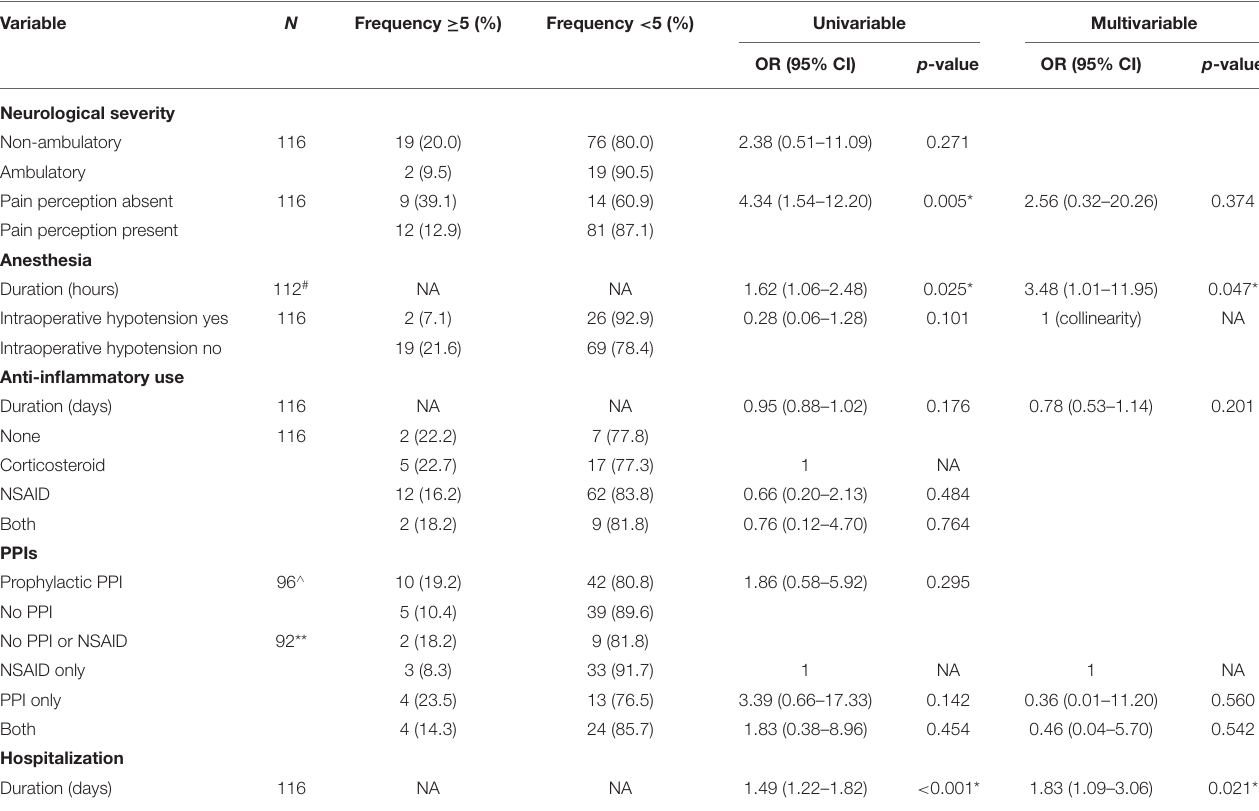
TABLE 7 | Univariable and multivariable analysis of risk factors for the severity of GI signs ( ≥ or < 5 episodes) in 116 dogs undergoing surgery for TL-IVDE. Variable N Frequency ≥ 5 (%) Frequency < 5 (%) Univariable Multivariable OR (95% CI) p -value OR (95% CI) p